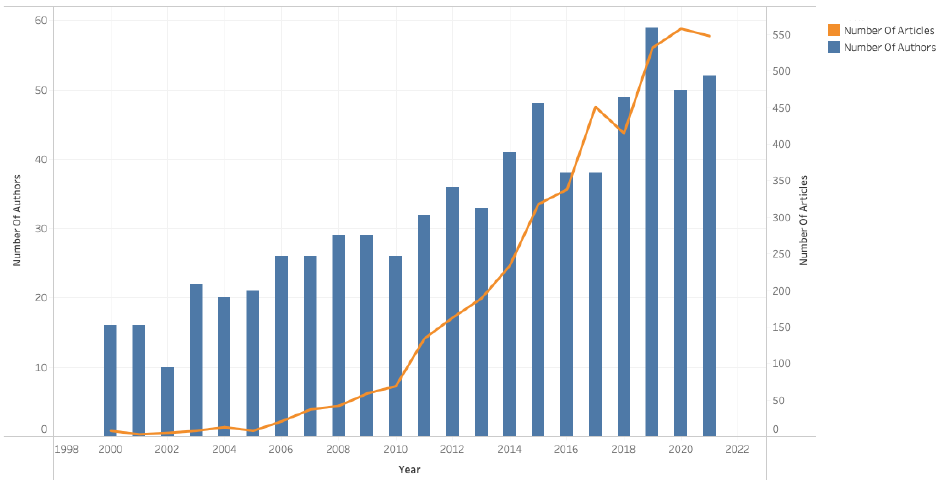
Figure 2. Number of published papers and the chronological distribution of authors of zero-energy building research.